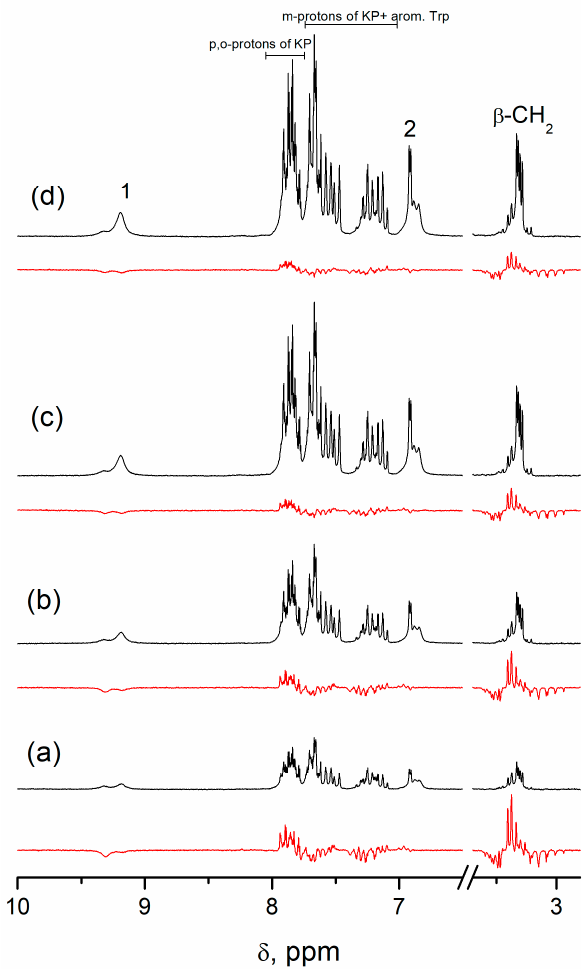
Figure 12. 1 H NMR (black) and CIDNP spectra (red) of diastereomers mixtures of dyad IV with the following concentrations: ( a ) 1.8 mM ( S,S )+ 4.1 mM ( R,S ); ( b ) 2.1 mM ( S,S )+ 9.3 mM ( R,S ); ( c ) 2.6 mM ( S,S )+ 17.7 mM ( R,S ); ( d ) 2.8 mM ( S,S )+ 21.2 mM ( R,S ) in CD 3 CN. 1 H NMR and CIDNP spectra of three optical configurations ( R,S )-, ( S,R )-, and ( S,S )-